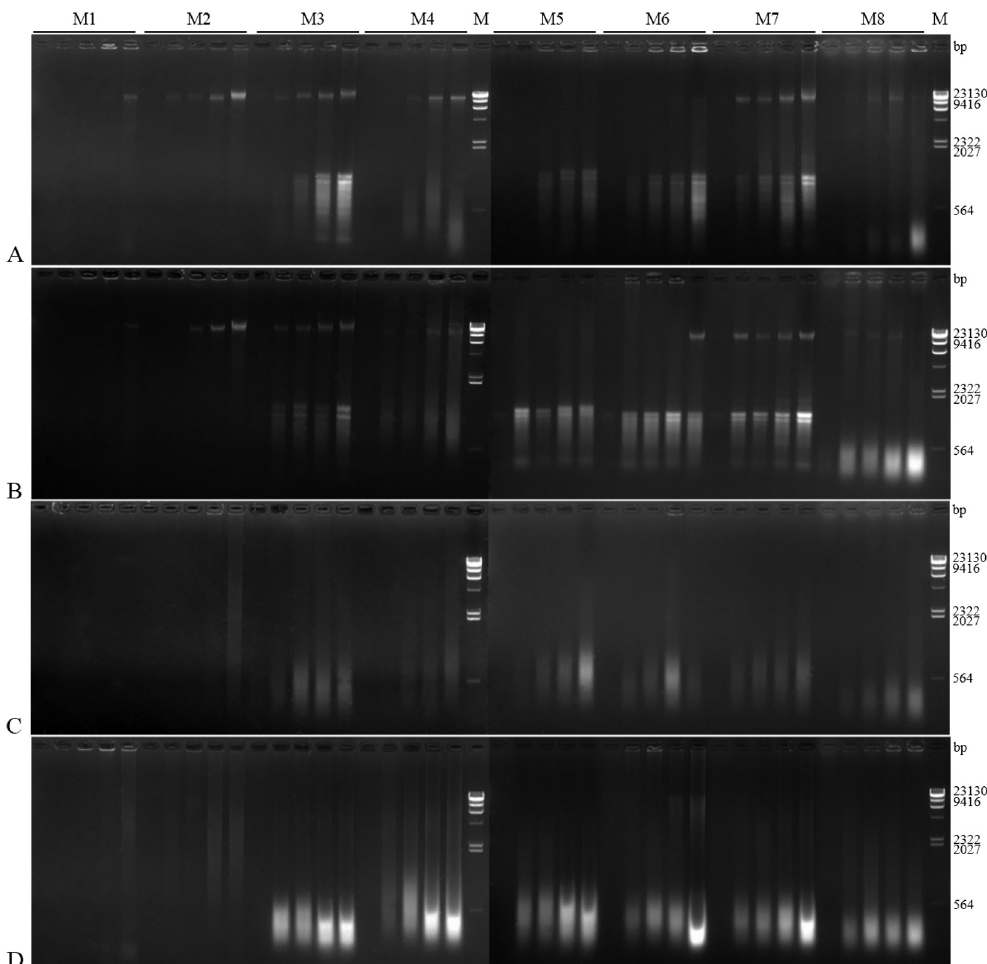
Fig 1. Electrophoresis of total DNA extracted from specimens preserved for four durations by using eight commonly used methods. (A-D) DNA extracted from specimens preserved for different durations (A: fresh, B: short period, C: intermediate period, D: long period; coded as I-IV in Table 1). Five lanes are shown for each method, from left to right: DNA samples extracted from an individual egg, and 1st, 2nd, and 3rd instar nymphs, as well as female adult mealybugs. M: λ - Hind III digest DNA